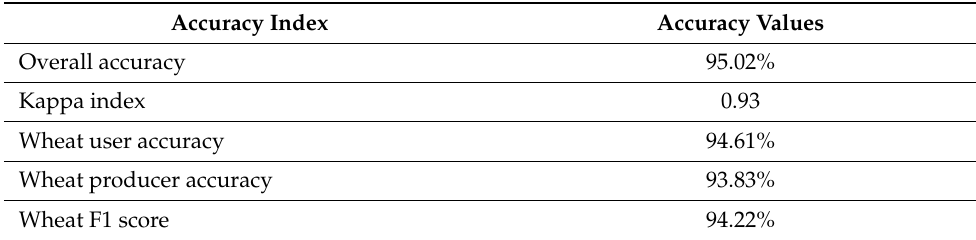
Table 6. Overall accuracy; Kappa index; wheat user and producer accuracy, and F1 score of the classification result.